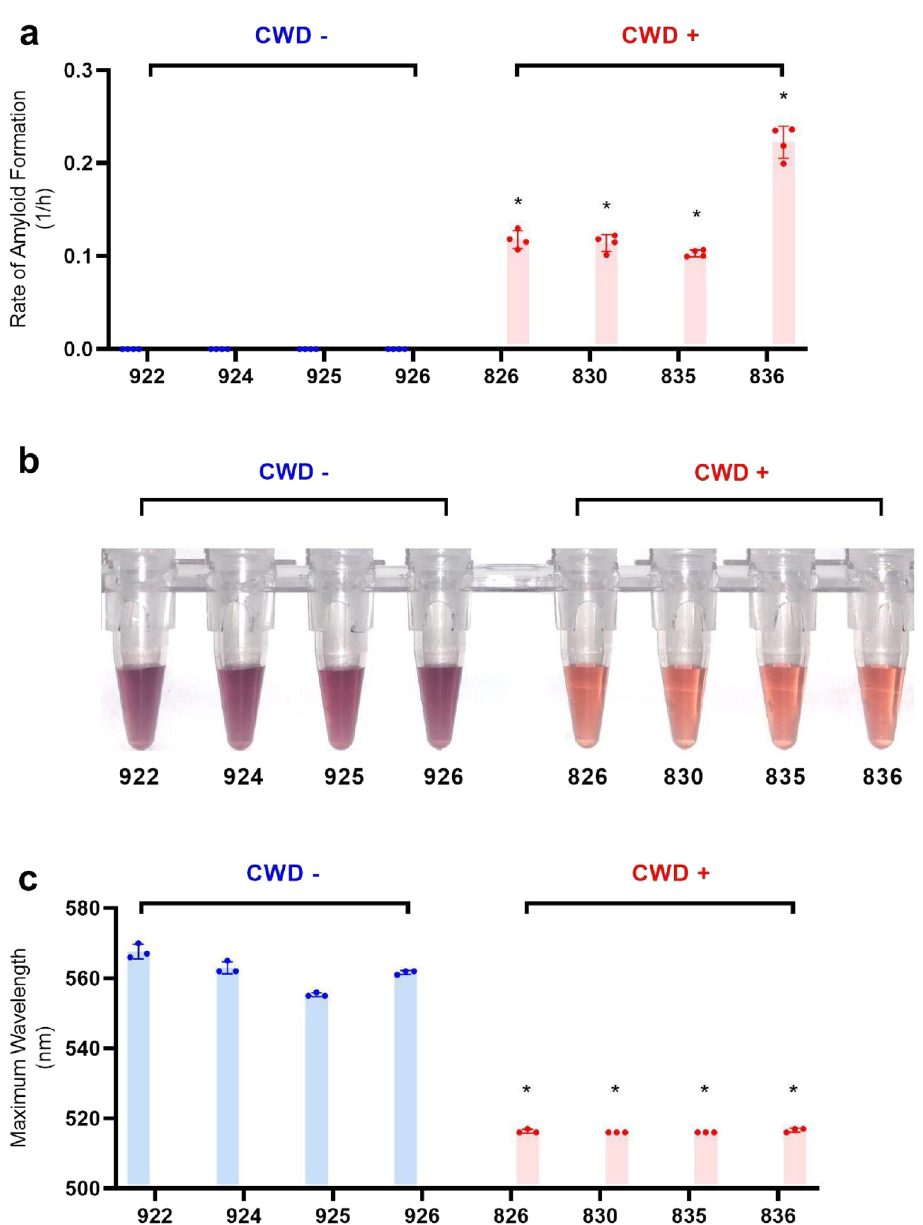
Figure 3. Comparison of RT-QuIC and MN-QuIC results for CWD positive and negative RPLN tissues. MNPRO sample identification number on the horizontal axis. ( a ) RT-QuIC data for the rate of amyloid formation for negative and positive RPLN tissue samples from wild WTD using ThT fluorescence. ( b ) Photo of MN-QuIC tubes showing the color difference for the same set of tissue samples used in ( a ). ( c ) MN-QuIC peak absorbance wavelength of the same set of solutions used in ( b ). *p-value < 0.05, error bars show standard